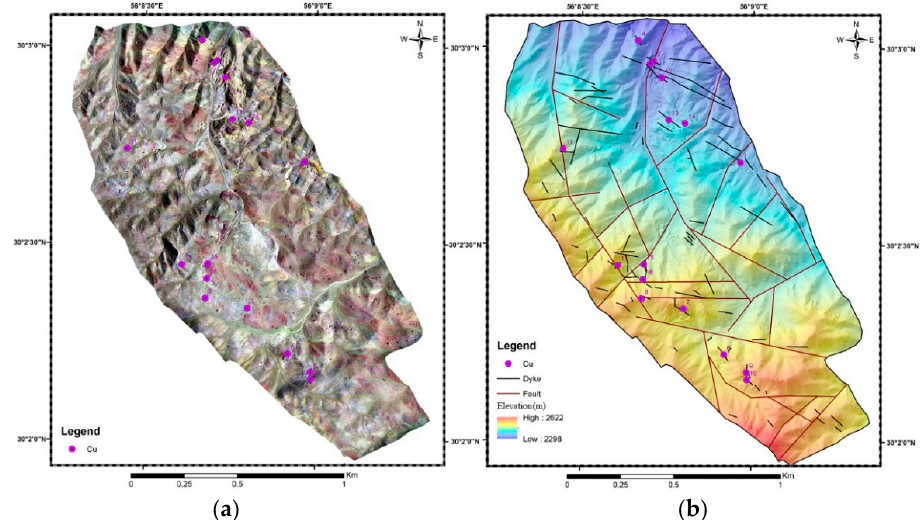
Figure 4. ( a ) Orthophoto image of the study area, and ( b ) hill-shade model containing lineament